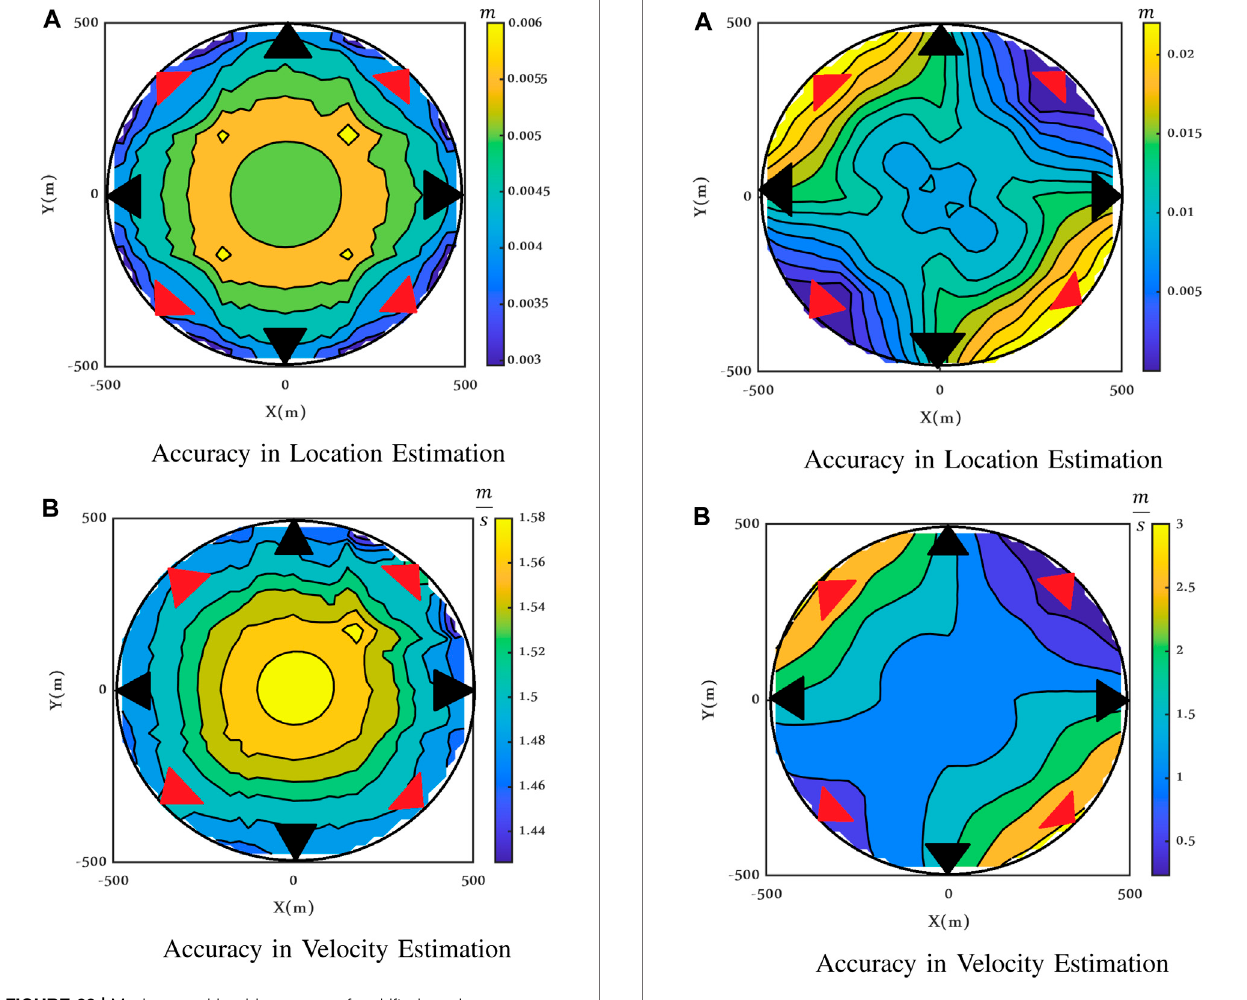
FIGURE 23 | Maximum achievable accuracy for shifted receiver antennaswhenthetargetismoving,ClutterModelII, ρ =0, ] =2.1,andSCR= − 15